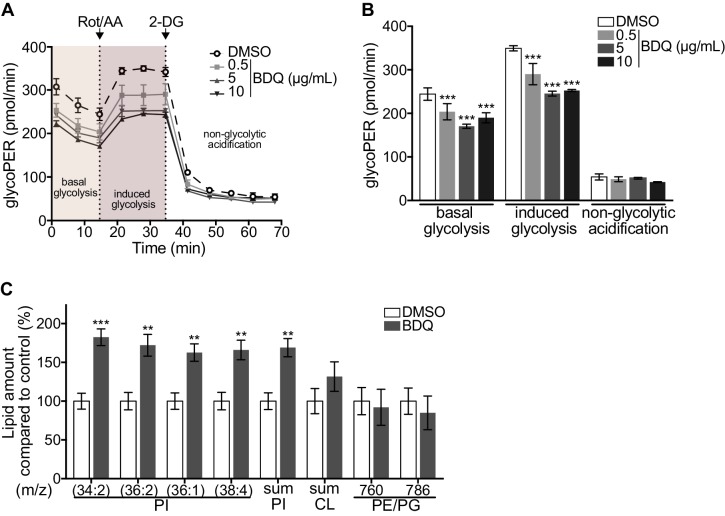
Modulation of host metabolism by BDQ.(A–B) The Glycolytic Rate Assay was performed in heat killed-MTB stimulated macrophages treated with BDQ, in the presence of rotenone/antimycin A (Rot/AA) and 2-deoxy-D-glycose (2-DG), inhibitors of the mitochondrial electron transport chain and glycolysis, respectively (one-way ANOVA test). One representative experiment (of two) is shown. (C) Lipid profile of BDQr-MTB infected cells treated with BDQ, by MALDI-TOF (unpaired two tailed Student’s t test). PI: Phosphotidylinositol; CL: Cardiolipids; PE: Phosphatidylethanolamine; PG: Phosphatidylglycerol. Numbers correspond to mass-to-charge ratio (m/z). Cells derived from three donors were analyzed. Error bars represent the mean ± SD and significant differences between treatments are indicated by an asterisk, in which *p<0.05, **p<0.01, ***p<0.001.